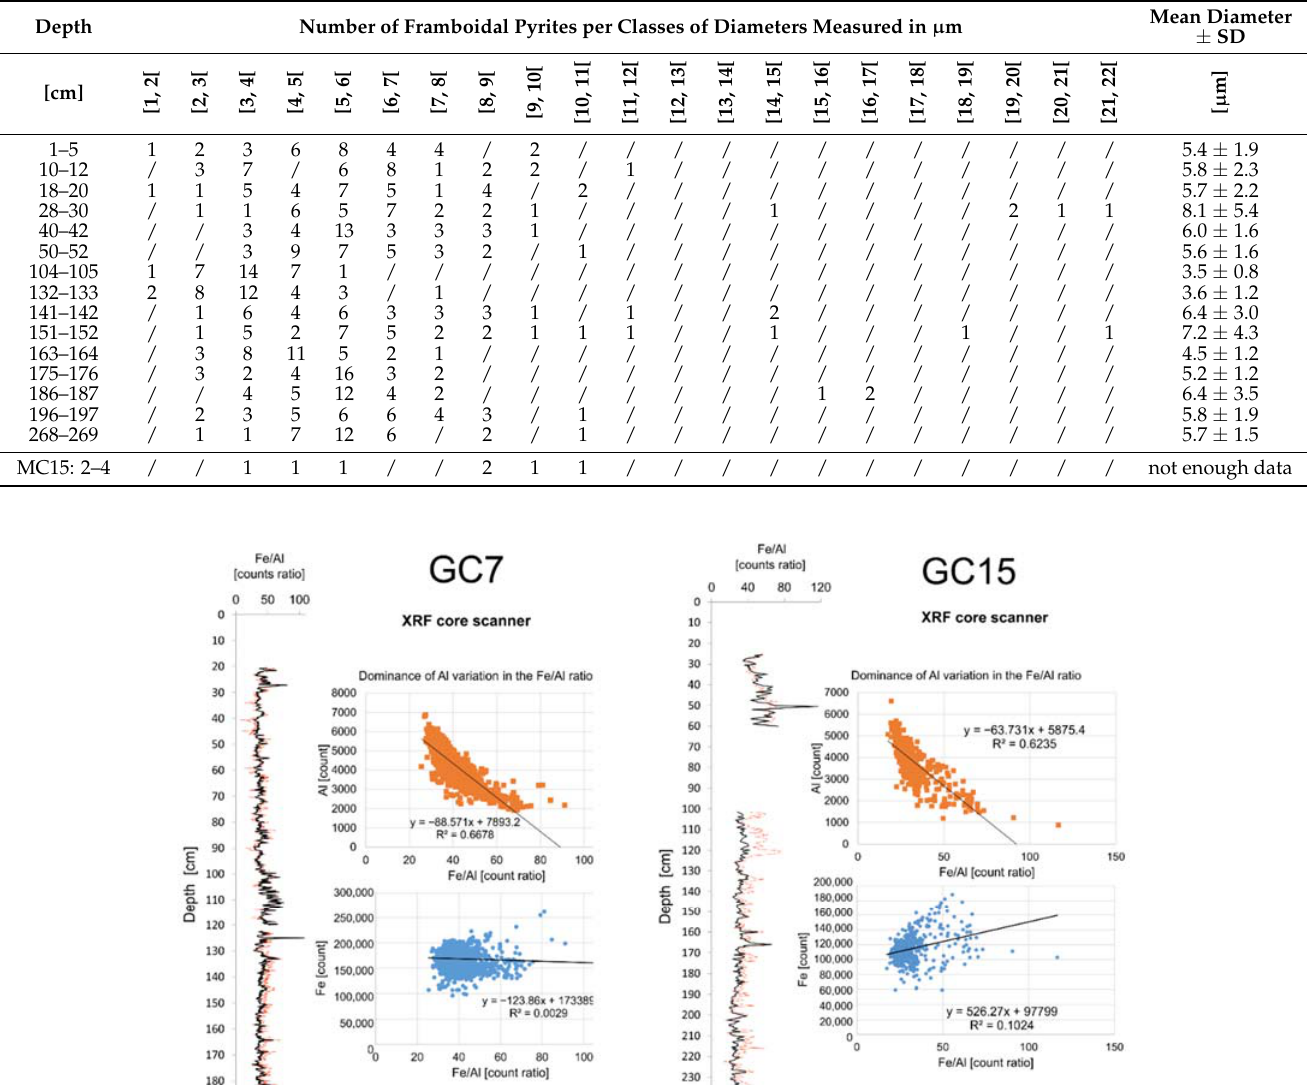
Table A6. Size distribution of the diameters of framboidal pyrites in 15 samples from GC15 (30 diameters) and one sample from MC15 (8 diameters).